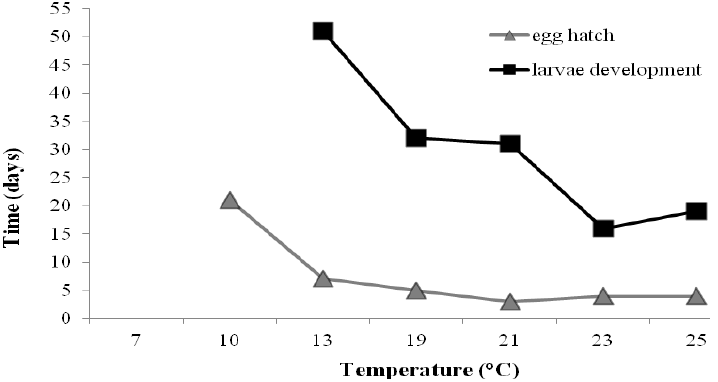
Figure 4. Time-span for Tuta absoluta egg and larval development at various